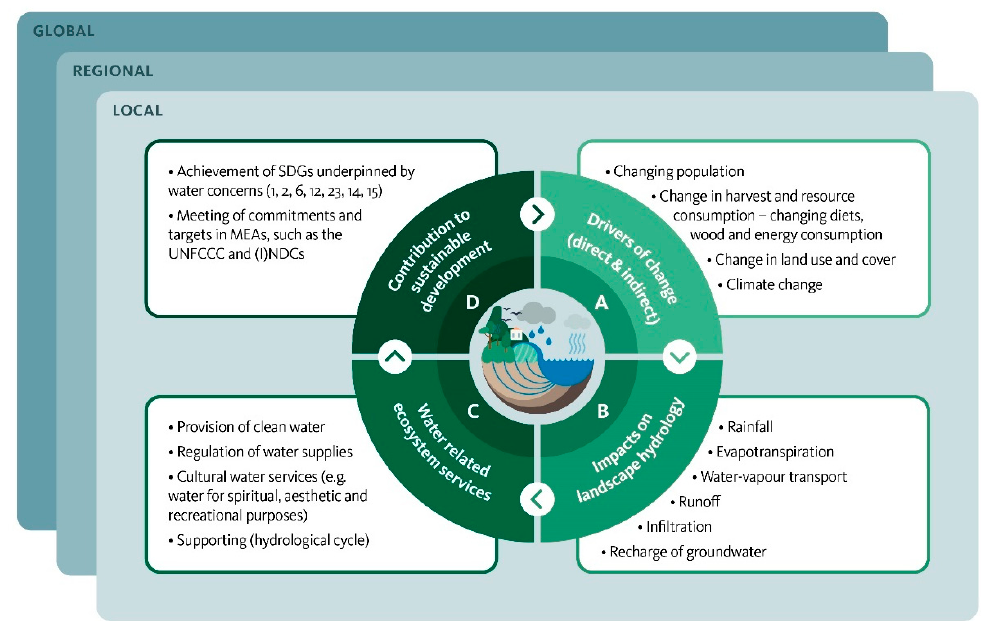
Figure 3. Conceptual framework for analysis of drivers of change, impacts on landscape hydrology and water-related ecosystem services and their contribution to sustainable development. (SDGs—Sustainable Development Goals; MEAs— Multilateral Environmental Agreements; UNFCCC-UN Framework Convention on Climate Change; (I)NDCs—(In- tended) Nationally Determined